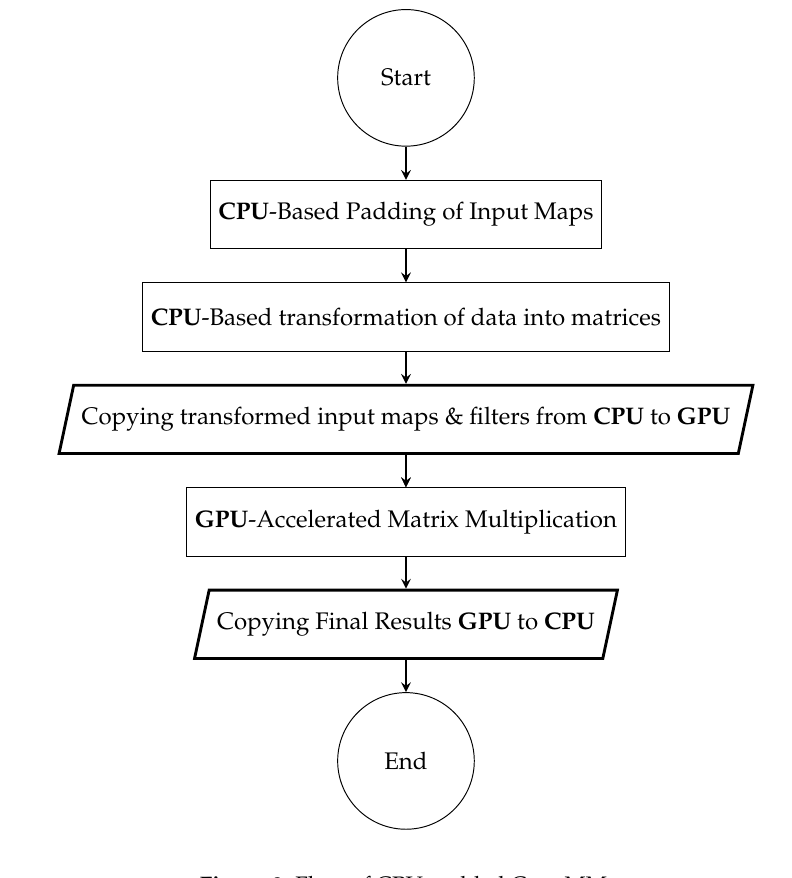
Figure 8. Flow of CPU padded